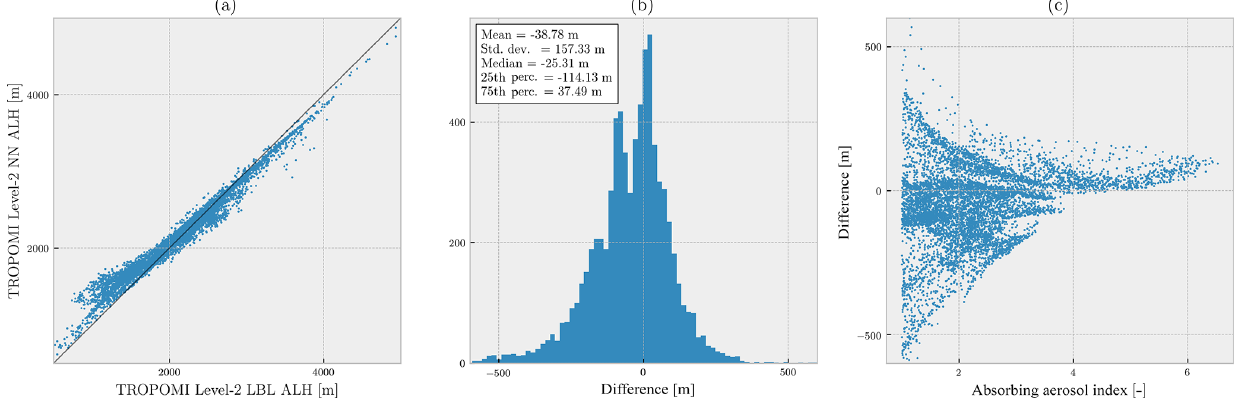
Figure 10. Comparison of retrieved aerosol layer heights from TROPOMI-measured spectra (orbit number 858) for the 12 December 2017 southern California fires using DISAMAR and NN. (a) Retrieved aerosol layer heights from the two methods. (b) Histogram of the difference between retrieved heights from DISAMAR and NN. The difference is defined as z aer ( DISAMAR ) − z aer ( NN ) . (c) Differences compared with TROPOMI’s operational AAI product ( x axis). Table 4. Statistics of difference between retrieved z aer from DISAMAR and NN from Fig.